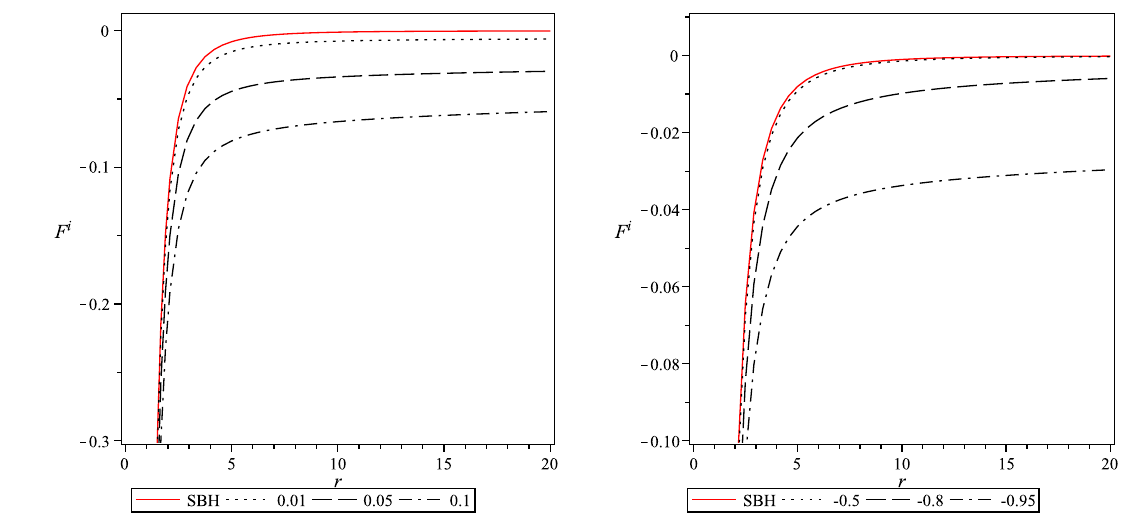
Fig. 3 Variation of angular tidal force of a unit mass SBH surrounded with cloud of strings and quintessence with radial distance from centre, left figure: w q = − 0 . 95 and different values of q as mentioned in the diagram. Right figure: q = 0 . 05 and different values of w q as mentioned in the diagram